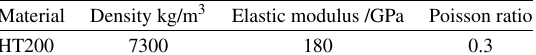
Fig. 1. Bionic design process of digging shovel.